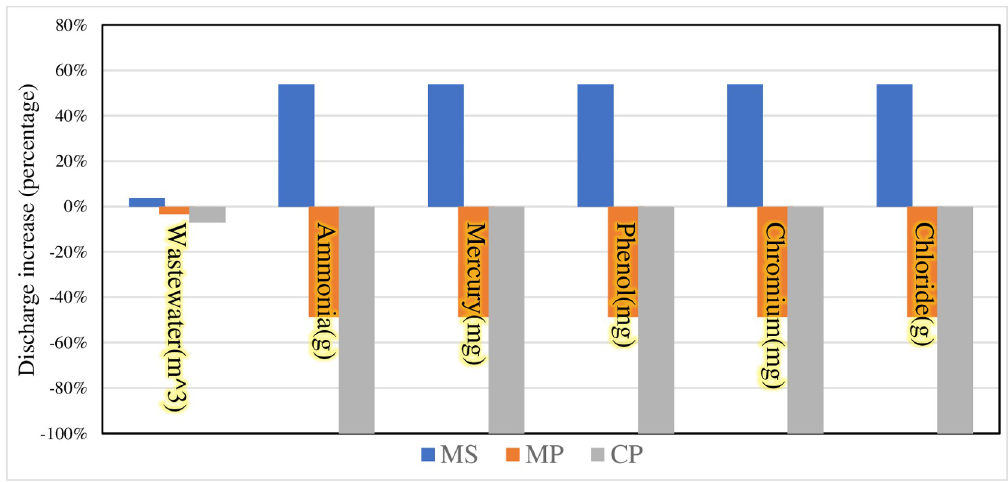
Fig 7. Bar graph depicting the percentage increase in wastewater and waste production compared to the BAU